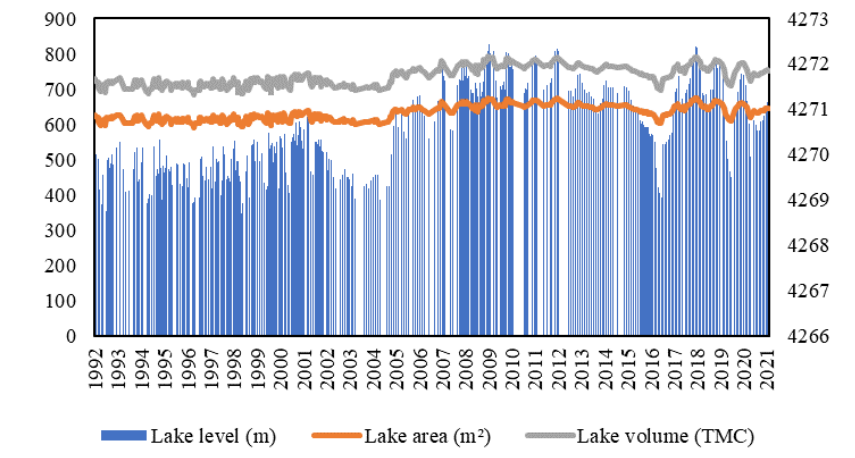
Figure 12. Observation results of water level, surface area, and water storage capacity of Ngoring Lake during the period